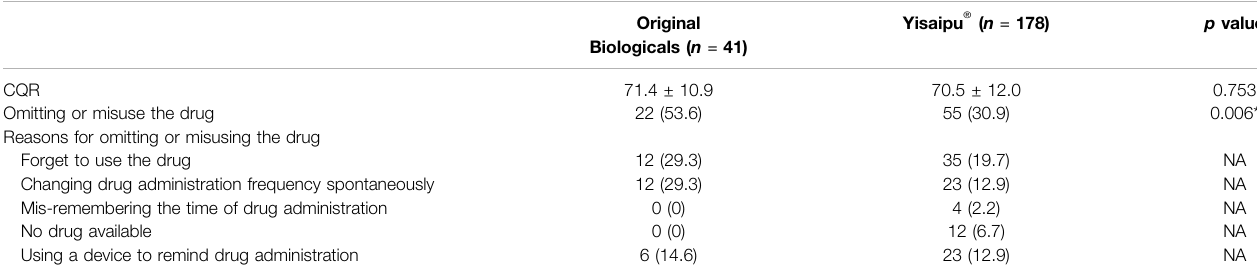
TABLE 3 | Compliance of